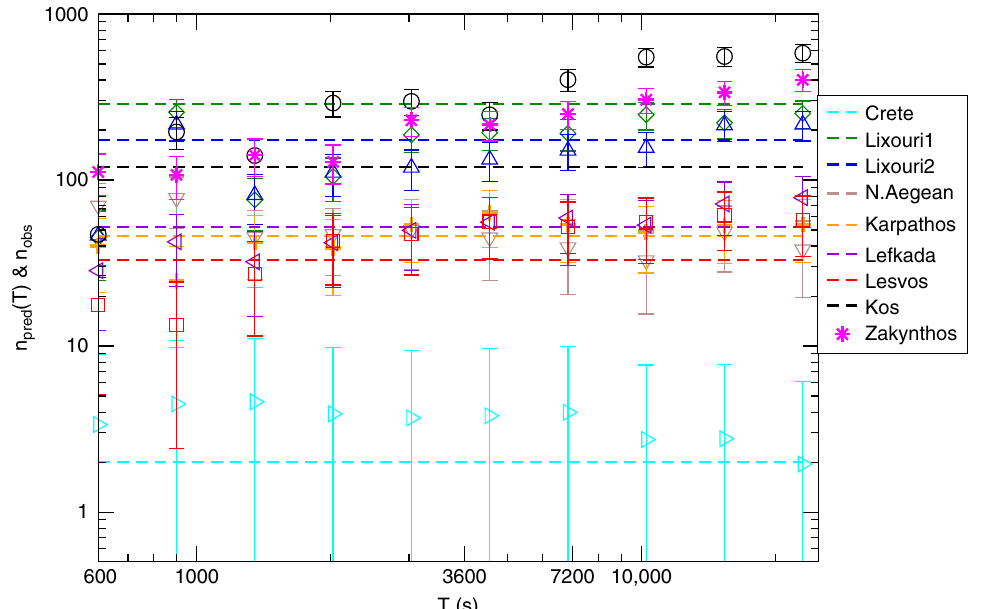
Fig. 7 Long-term test of the method for the recent Aegean earthquakes. The same plot as in Fig. 6 for the number of predicted aftershocks n pred ( T ) (open symbols) with μ i > μ M − 3 in the testing period [7, 90] days. Dashed horizontal lines is the number of aftershocks with m i > M m − 3 recorded in the Greek catalog in the interval [7, 90] days. Aftershocks are de fi ned as events occurring within a radius of size L M ¼ 0 : 02 ´ 10 0 : 5 m M from each mainshock